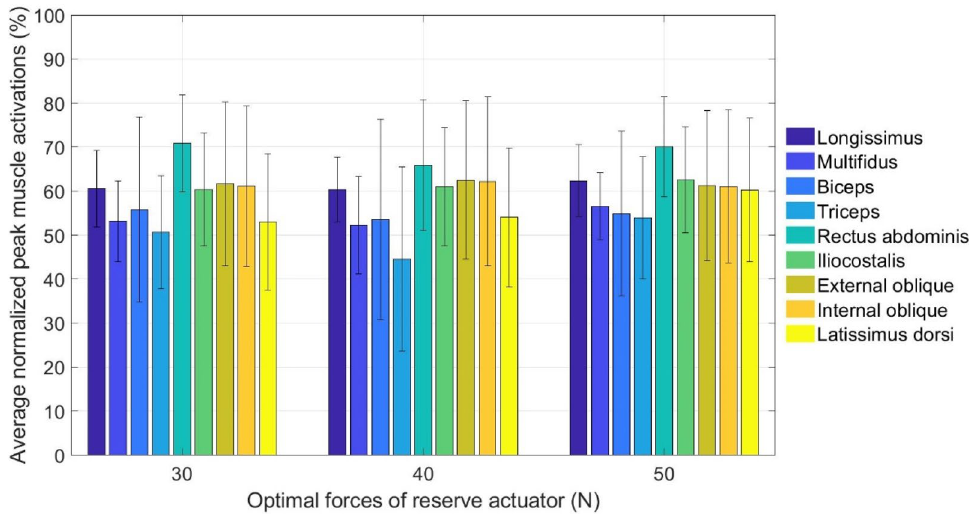
Figure 4. Average normalized peak muscle activations of harvesters at different F RA – 30 N, 40 N and 50